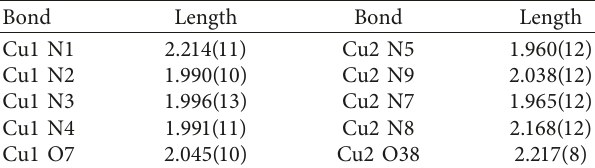
Table 3: Antibacterial activities of compounds 1–6